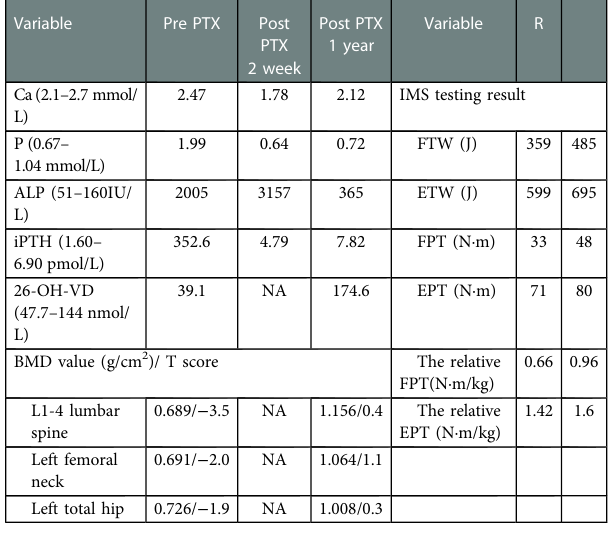
TABLE 5 Changes in biochemical indices and BMD before and after PTX and the IMS test results at one year after PTX.